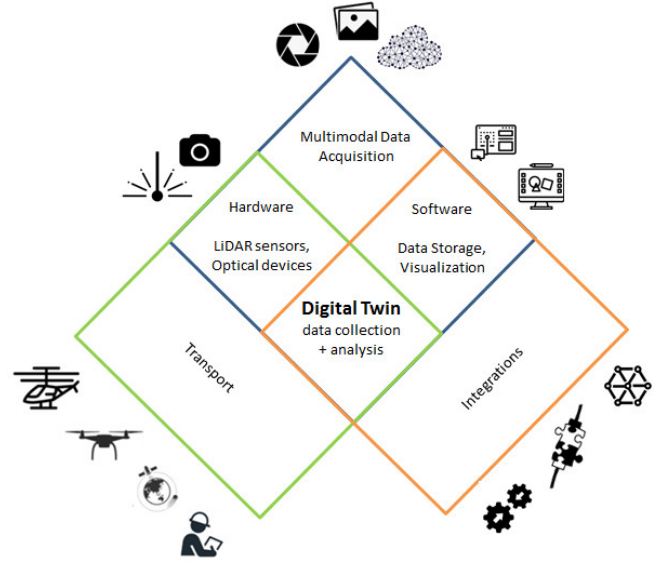
Figure 10. Hardware and software integration for automatic data collection and data